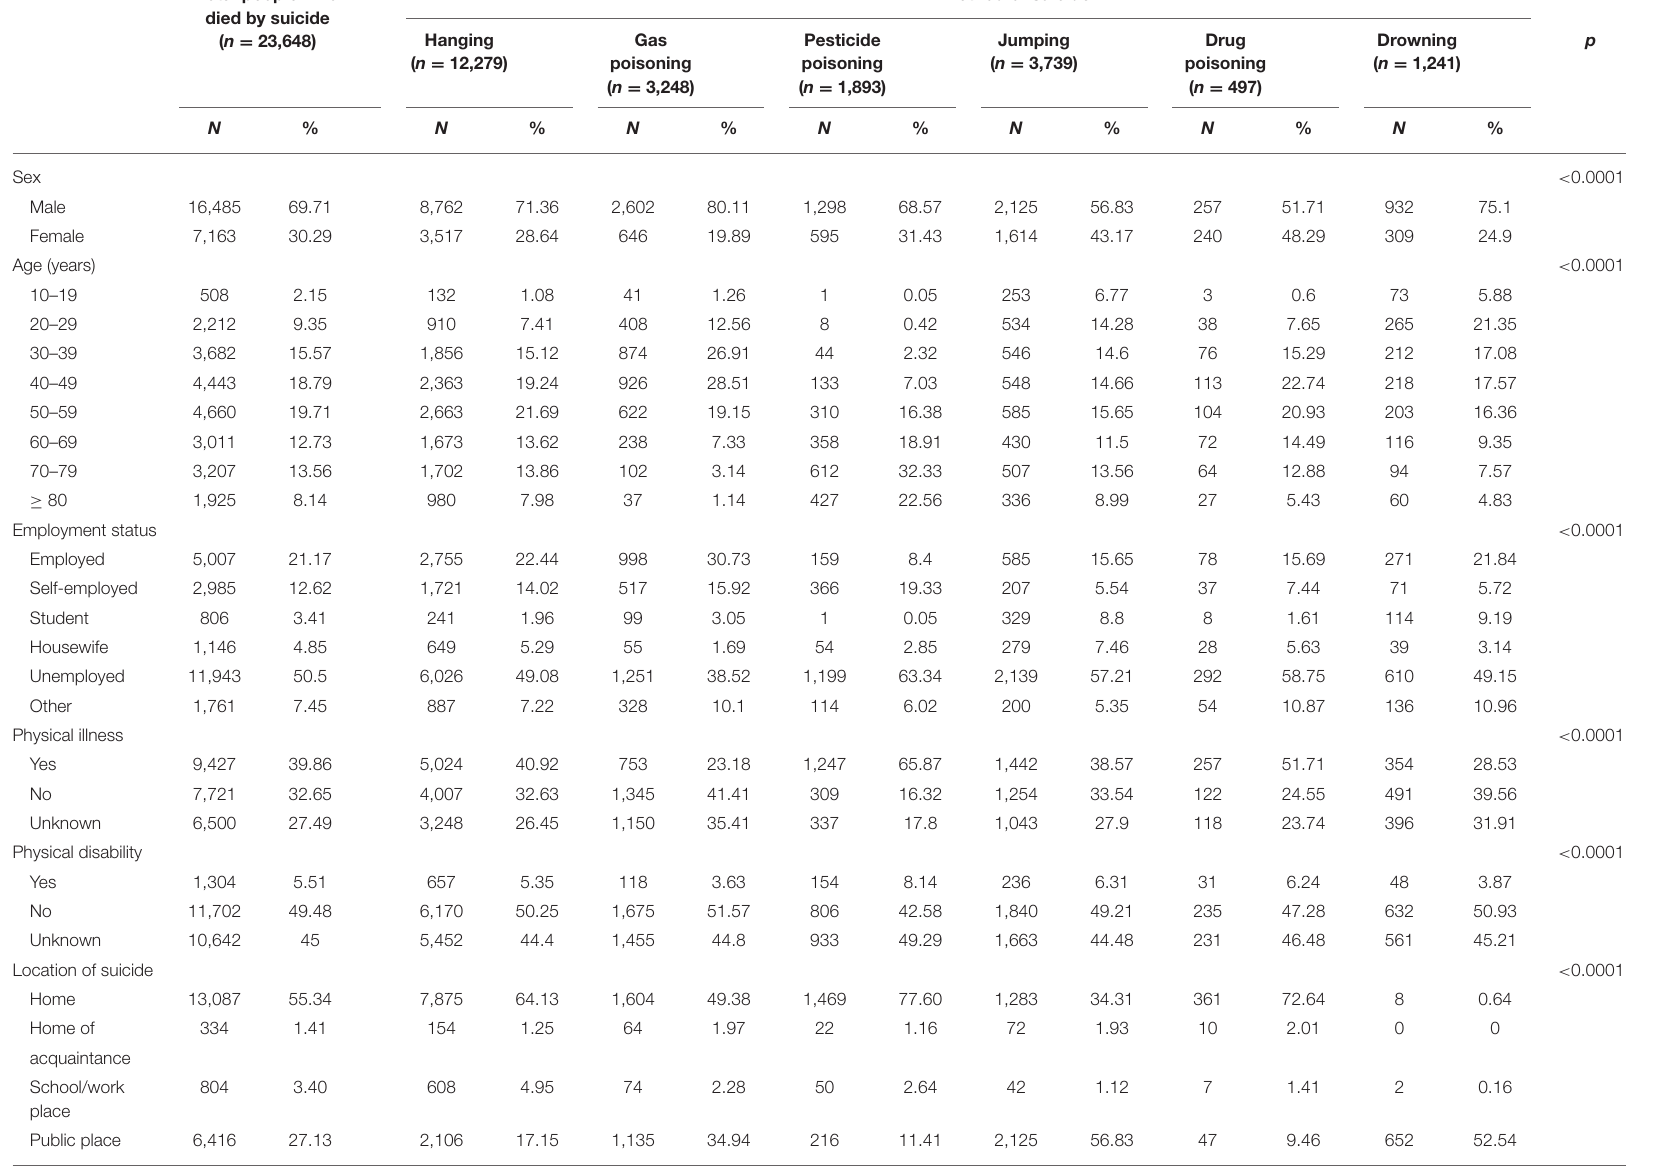
TABLE 1 | Demographic and suicide characteristics of people who died by